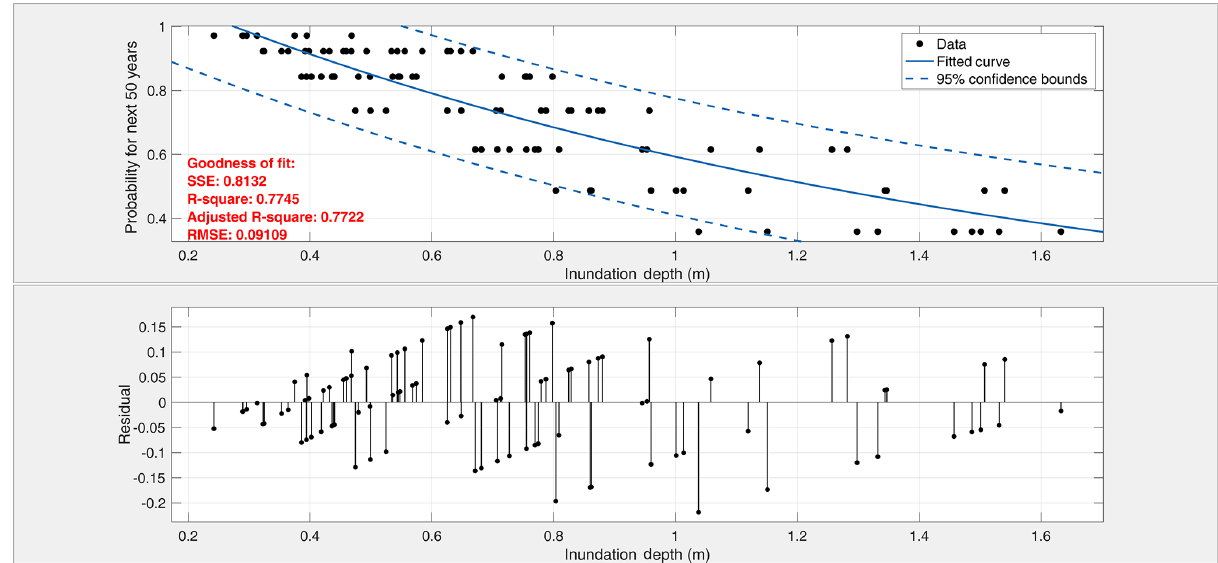
Figure 6. Probabilities of exceedance corresponding to maximum water surface elevation, minimum water surface elevation, and inundation depth for the next 50 years. Black dots represent the probability of exceedance of the tsunami hydrodynamic parameter for each event in the catalog. The blue line is the best fit curve to the data and the dashed blue line is the 95% confidence boundary of the fitted curve. The residual of the fit is represented for each probability